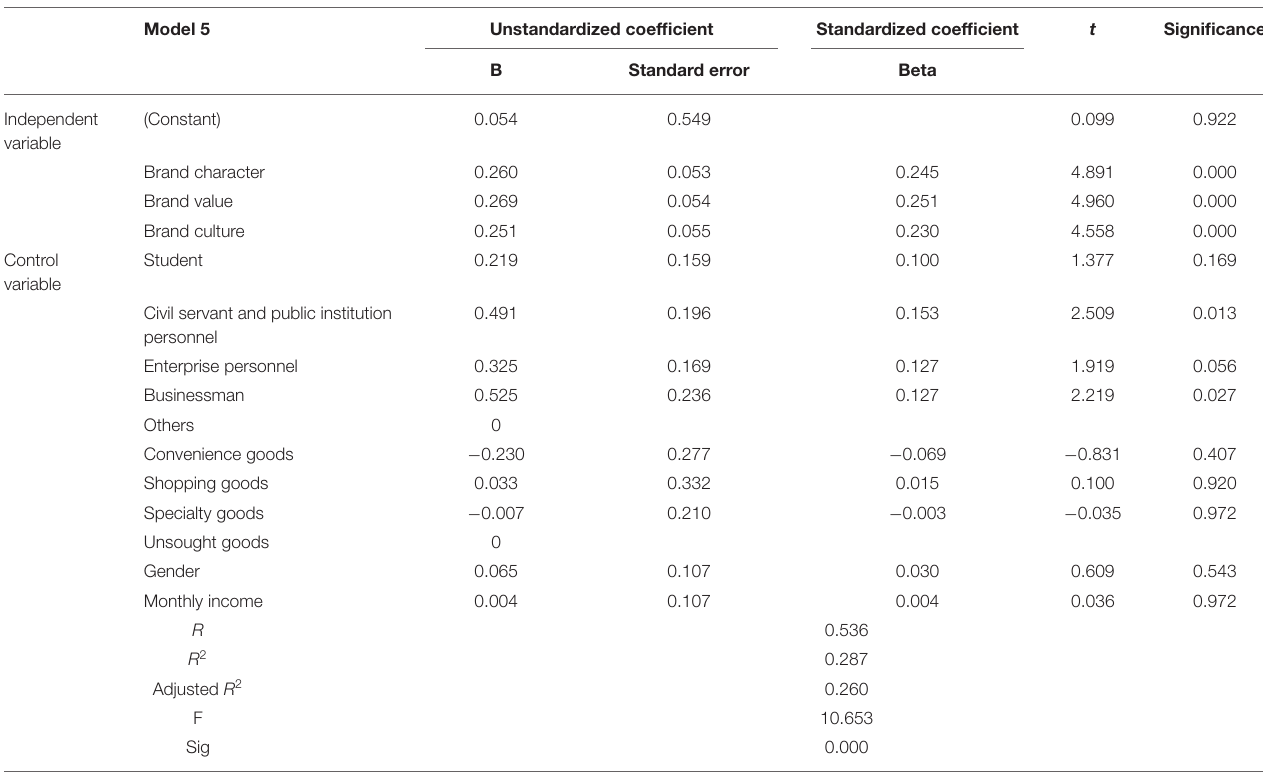
TABLE 6 | Regression analysis of each dimension of brand elements to the emotional